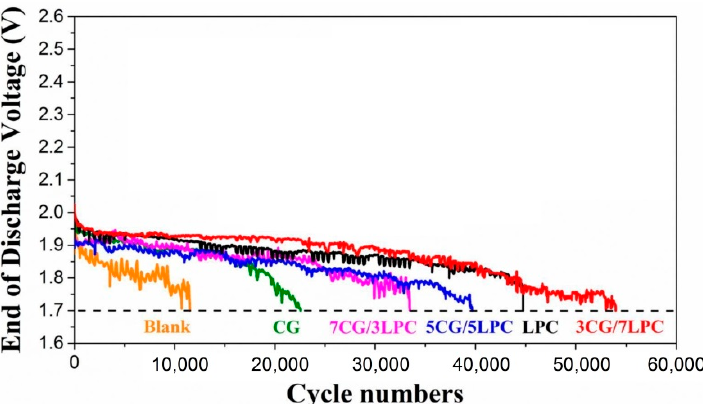
Figure 1. Comparison of number of cycles completed in HRPSoC conditions for lead–acid batteries with various carbon additives, conductive graphene (CG), and lead-doped porous carbon (LPC) with different mass ratios. HRPSoC regime: charge at C/5 for 90 s (voltage limit of 2.35 V), rest for 10 s, discharge at C/5 for 60 s, and rest for 10 s. Adapted from [31] with permission from Elsevier.